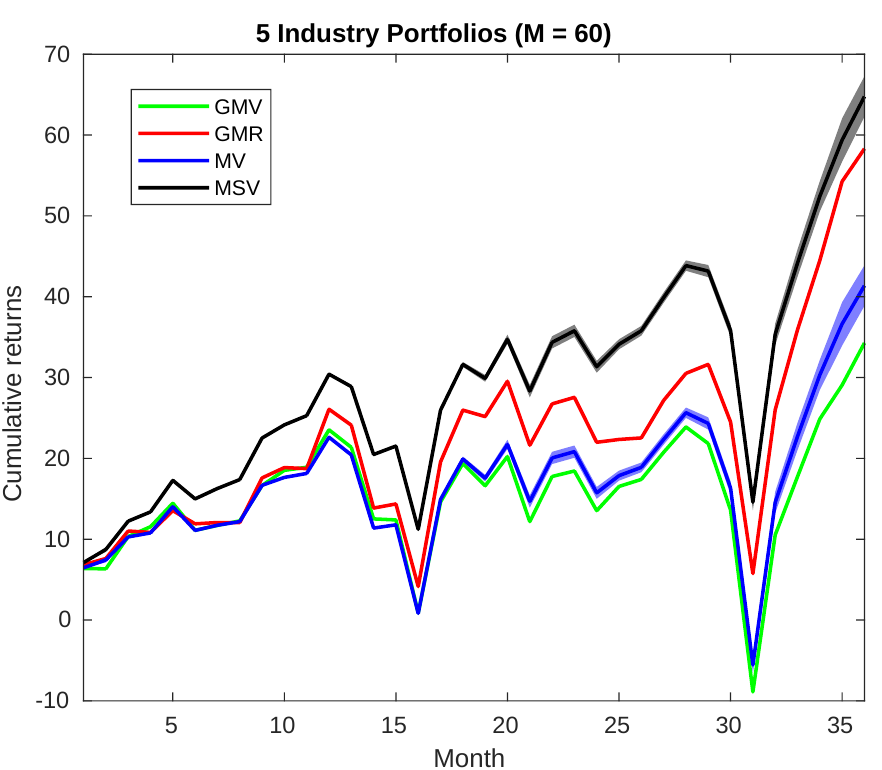
Figure 1. Cumulative monthly returns plot of the four portfolios implemented from 1 September